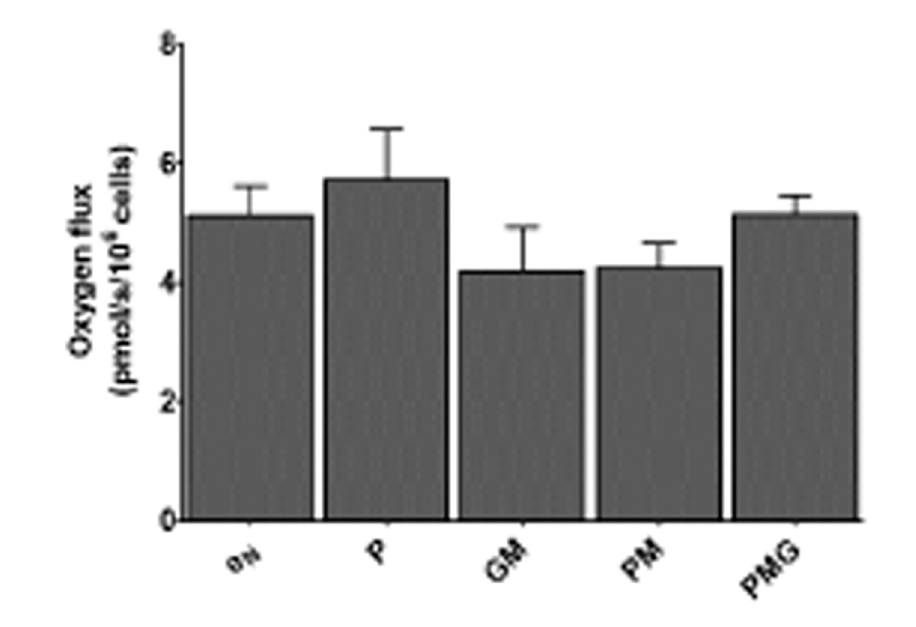
Fig 5. Phosphorylative capacities of different NADH-linked substrate combinations. The graph shows the ability of different substrate combinations of pyruvate (5 mM), glutamate (10 mM) and malate (0.5 mM) to stimulate respiration in the presence of ADP (2.5 mM). State 1 (e N ) is used as a control state. No difference was found between state 1 respiration and the OXPHOS states of the different substrate conditions. e N : endogenous respiration without reducing substrates or ADP (six measurements), P: pyruvate (three measurements), GM: glutamate and malate (six measurements), PM: pyruvate and malate (three measurements), PMG: pyruvate, malate and glutamate (three measurements). Fluxes are expressed as means ±